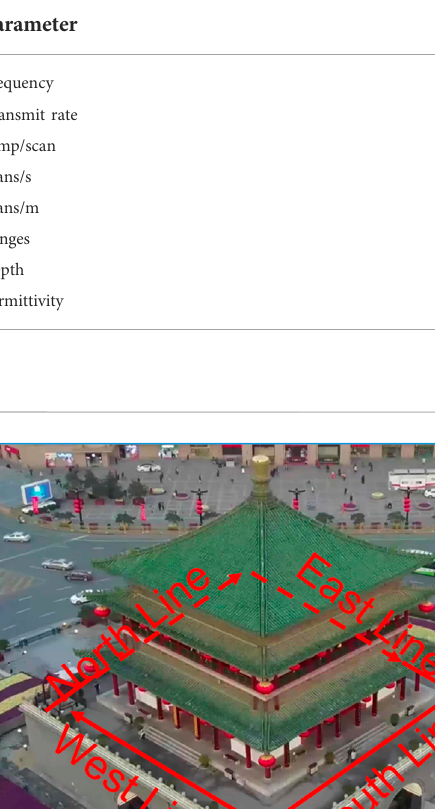
TABLE 4 GPR parameter settings.